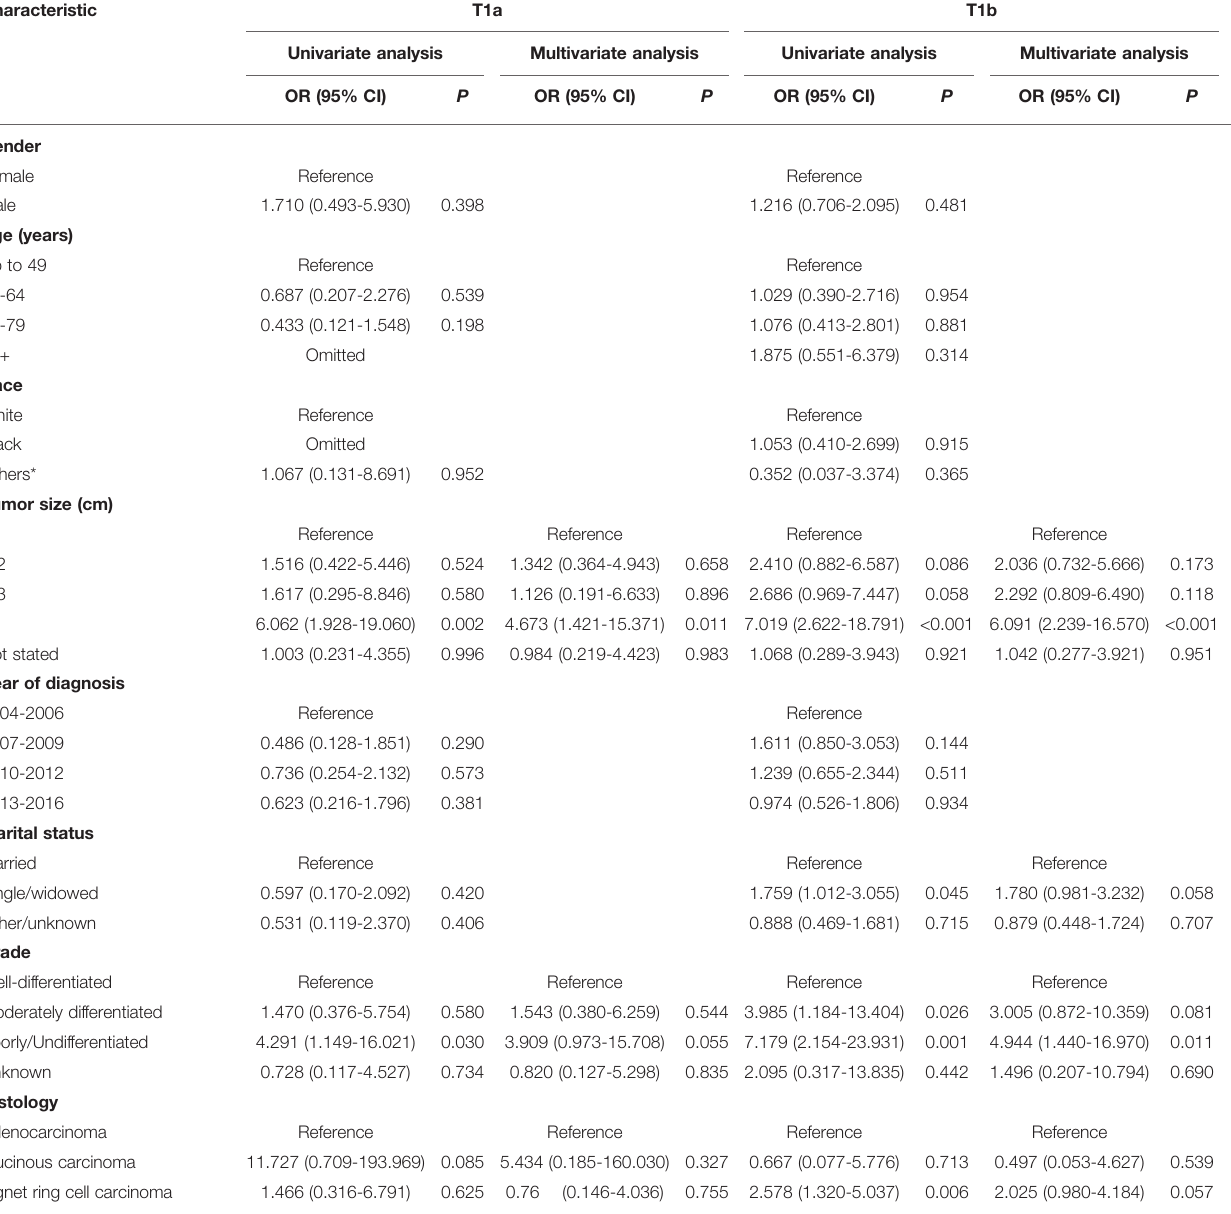
TABLE 3 | Logistic regression analysis of the risk factors for lymph node metastasis in T1a and T1b esophagogastric junction cancer (LNE ≥ 16).